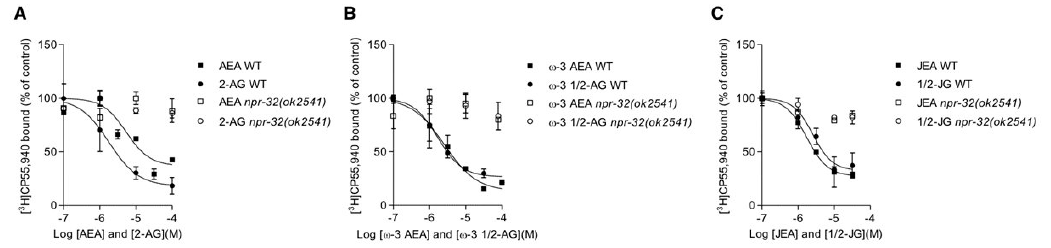
Figure 10. Binding activities of ECs on membrane preparations of N2 (WT) and npr-32(ok2541) mutants. WT (full dots) and npr-32(ok2541) (empty dots) membranes were incubated with 3 nM [ 3 H]CP55,940 in the presence of different concentrations (0.1 to 100 μ M) of ( A ) AEA and 2-AG ( B ) ω -3 AEA and ω -3 1/2-AG and ( C ) JEA and 1/2-JG. Data show displacement curves with mean values ± SD of at least three independent experiments each performed in triplicate.